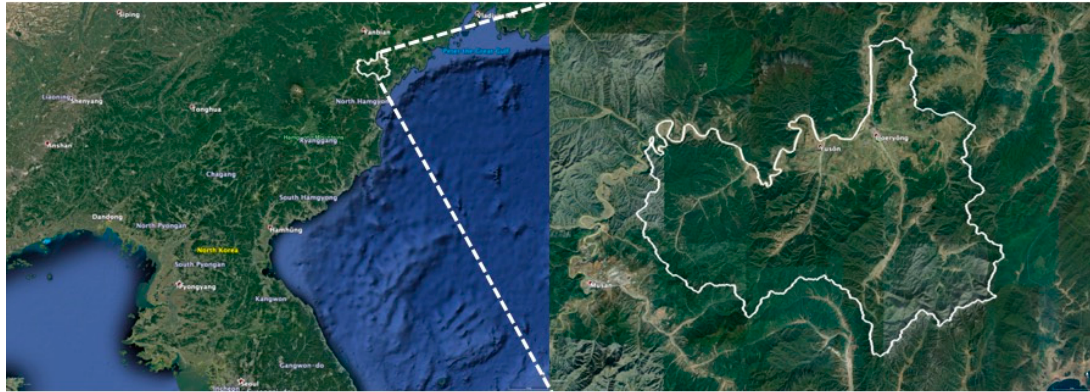
Figure 1. Satellite images of the study area (source: Google Earth imagery).